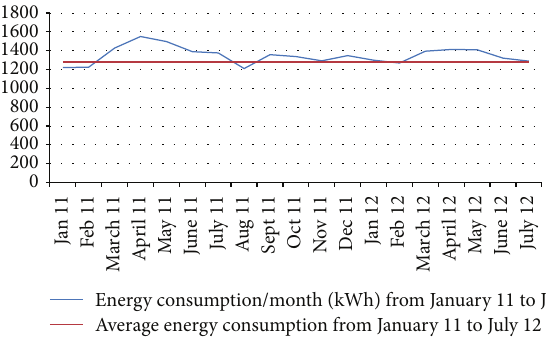
Figure 7: Monthly energy consumption curve, MTN Maroua Market site from January 11 to July